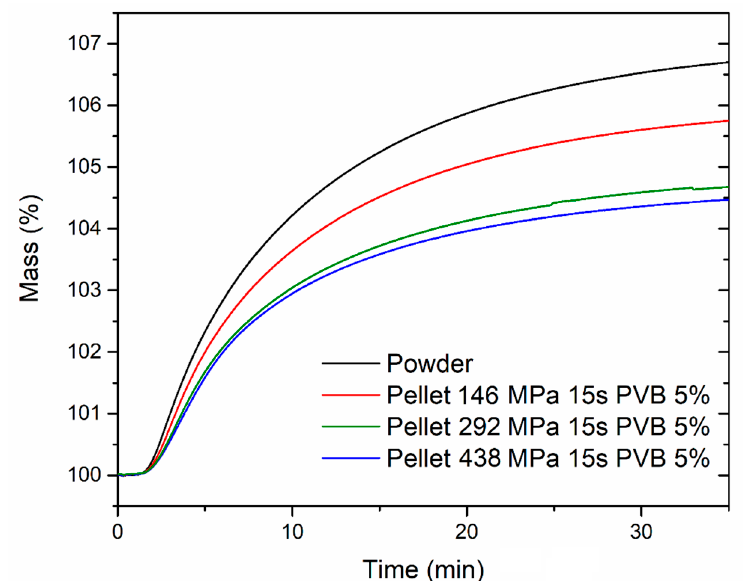
Figure 10. Dynamic CO 2 adsorption curves for MOF-801 powder (black) and pellets containing 5 wt % PVB prepared by compressing for 15 s under 146 (red), 292 (olive) and 438 (blue) MPa pressure. The experiments were performed under 1 atm CO 2 . The delayed onset of adsorption was due to non-immediate saturation of the TGA chamber with CO 2 upon switching from Ar after activation.